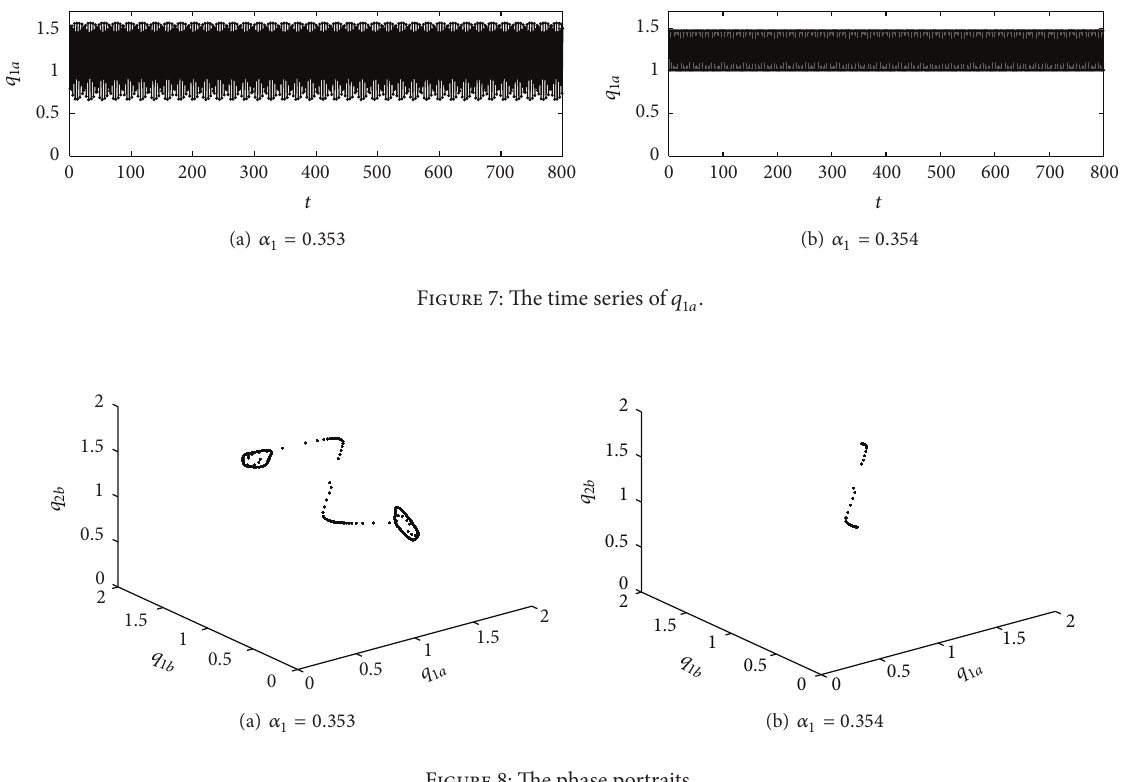
Figure 8: The phase